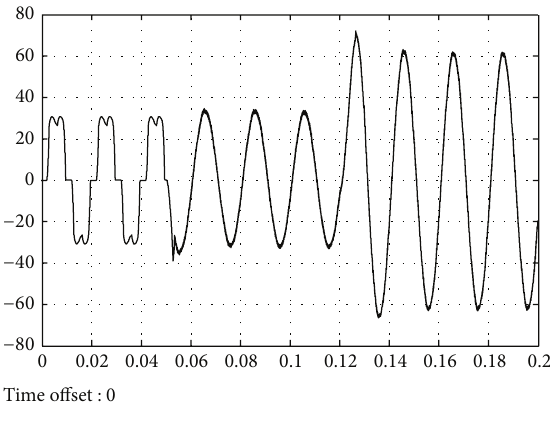
Figure 4: A phase